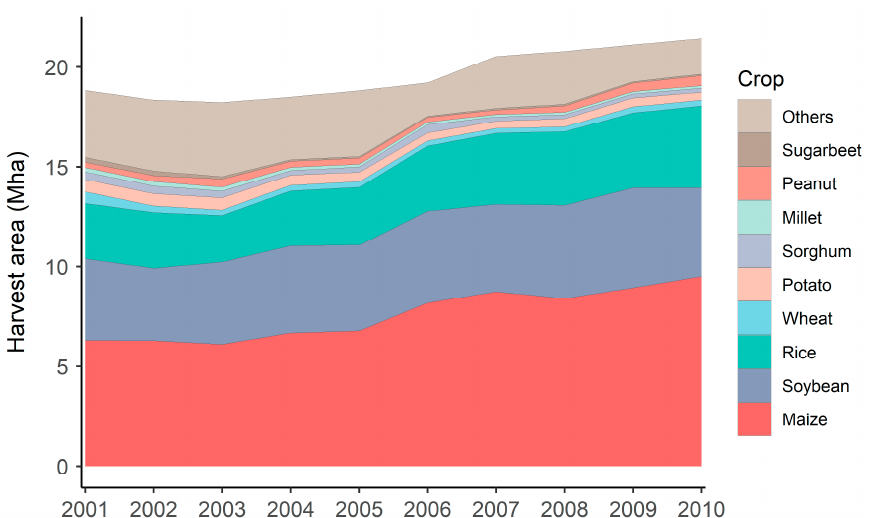
Figure 2. Harvest area of major crops in Northeast China from 2001 to 2010. Mha, million hectares.